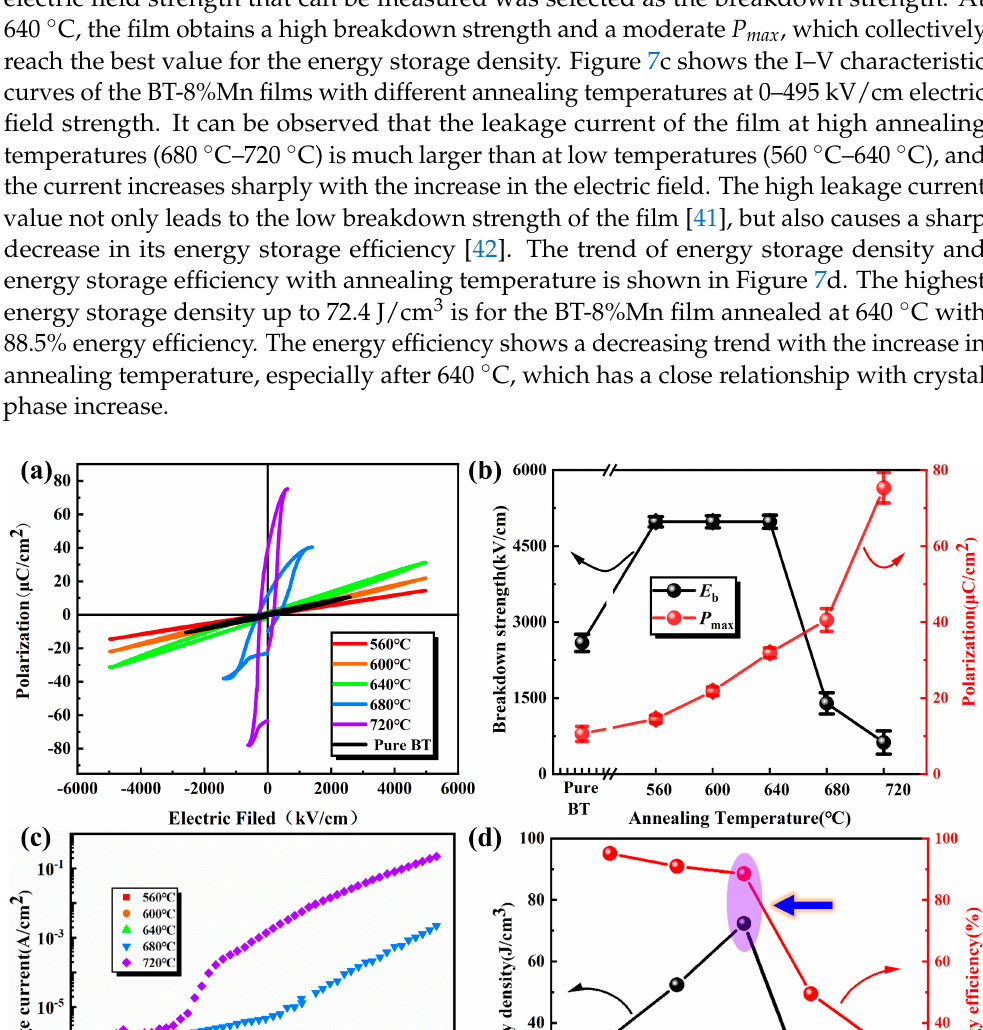
9 of 13 Figure 6. Image of BT-8% Mn films dielectric properties with temperature at 10 5 Hz: ( a ) dielectric constant; ( b ) dielectric loss. The P-E loop is an important parameter reflecting the energy storage performance of the films. Figure 7a shows the P-E loop plots of the films at different annealing tempera-